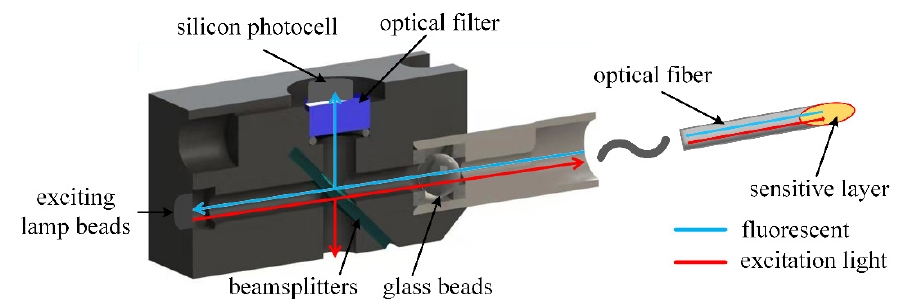
Figure 5. Schematic diagram of the structure of the optical path component.